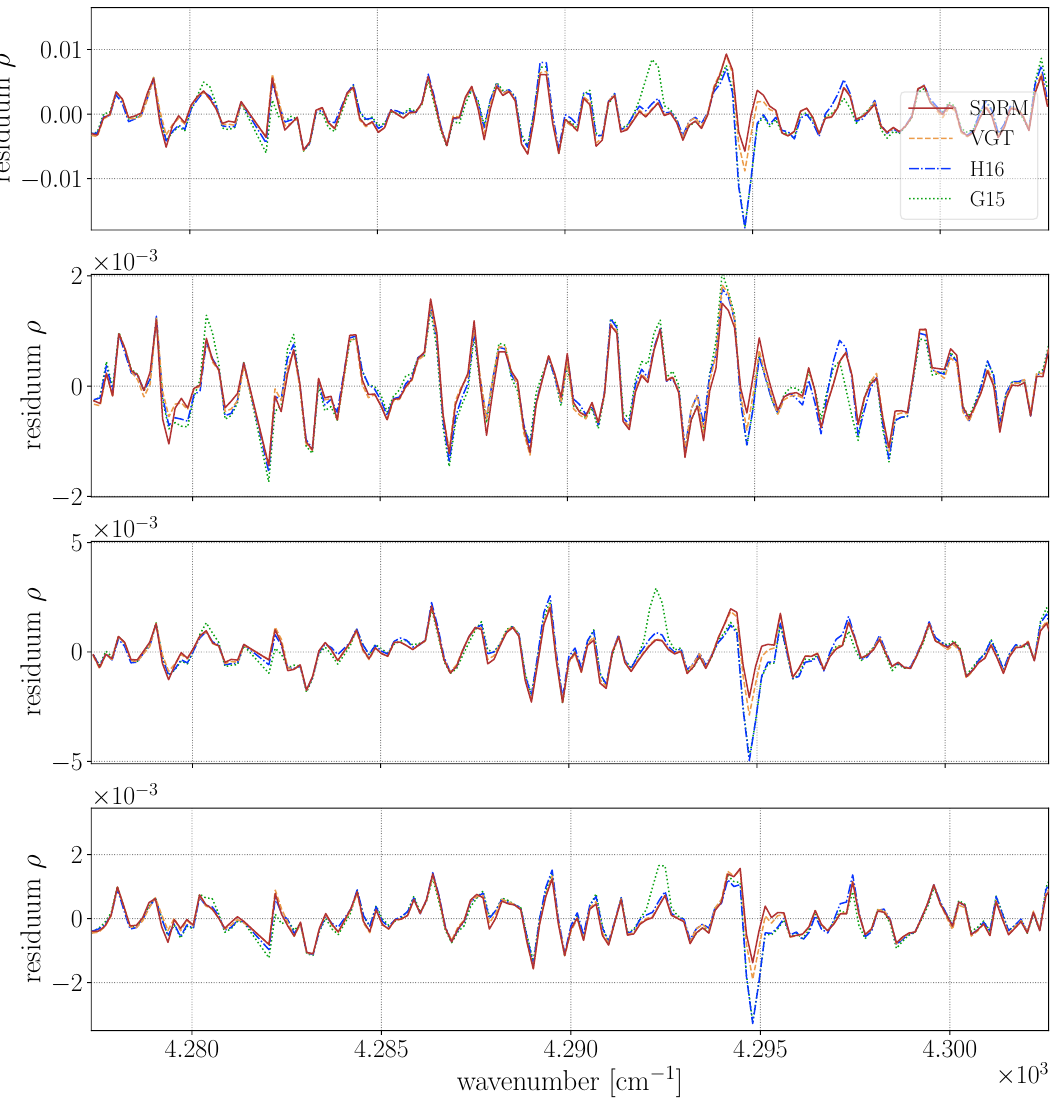
Figure 9. Spectral residuals for a measurement over the Sahara, Central-Europe, Amazonia, and Siberia (from top to bottom) in spring 2019, respectively. The observations were randomly picked; however, the largest disagreements appear to be at similar wavenumbers across the different regions, most prominent close to 4295 cm − 1 and particularly pronounced in the fits with the two Voigt